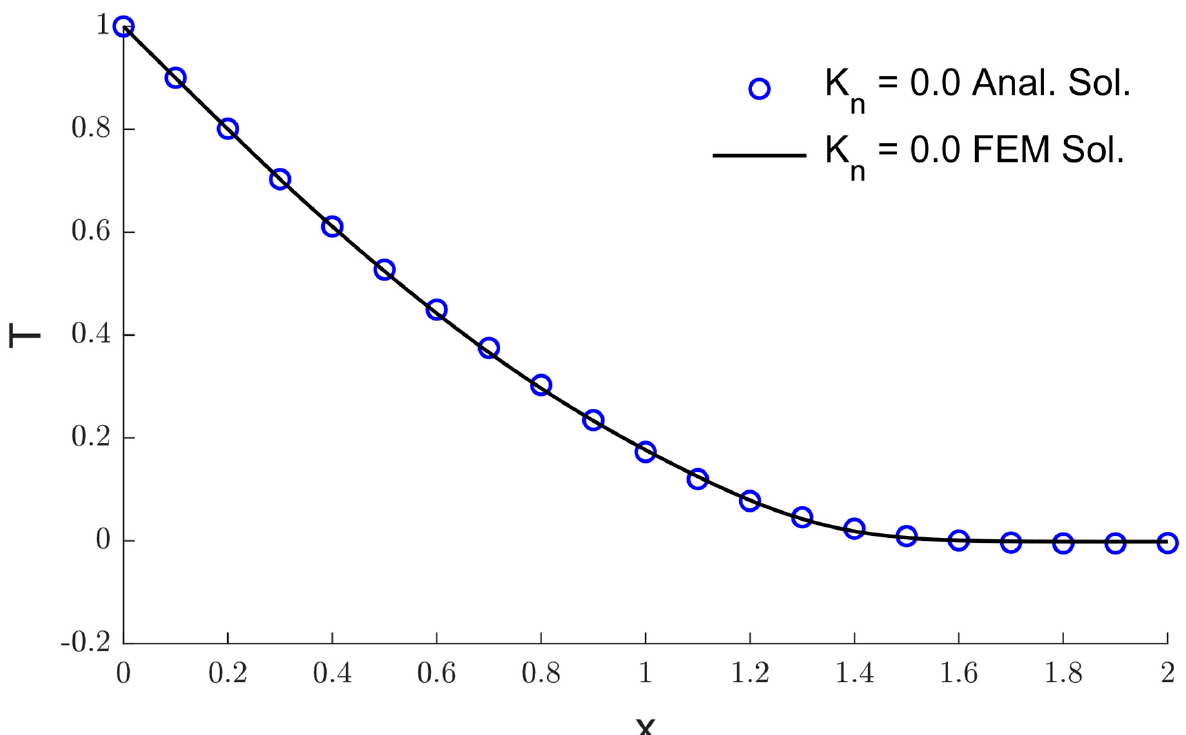
Figure 11. The temperature comparison study when τ o = τ 1 = 0.05 and K n = 0 .